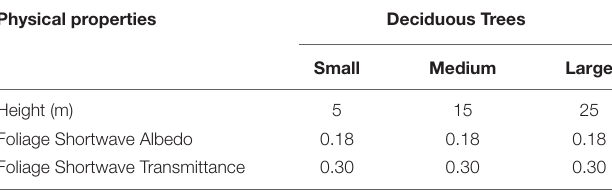
TABLE 2 | Physical properties of the vegetation used in the ENVI-met model.